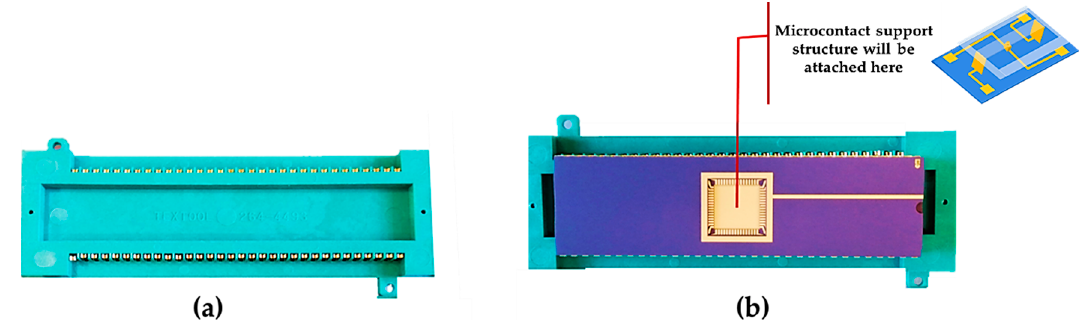
Figure 11. ( a ) Carrier socket; ( b ) package placed into the carrier socket.